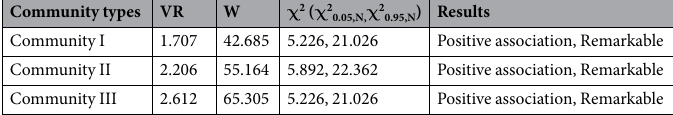
Table 4. Overall associations among dominant